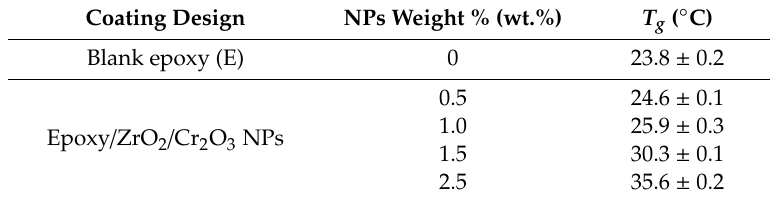
Table 1. T g results for ZrO 2 / Cr 2 O 3 epoxy nanocomposite coating films.